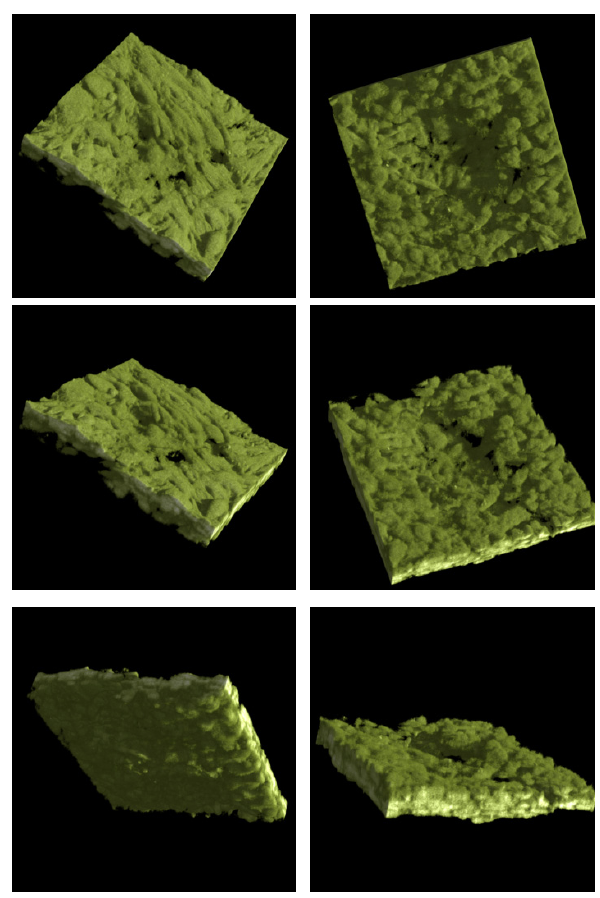
Figure 16. 3D rendered confocal image of less porous alumina Sample B with SBF coating that was sintered with 24d cell culture.